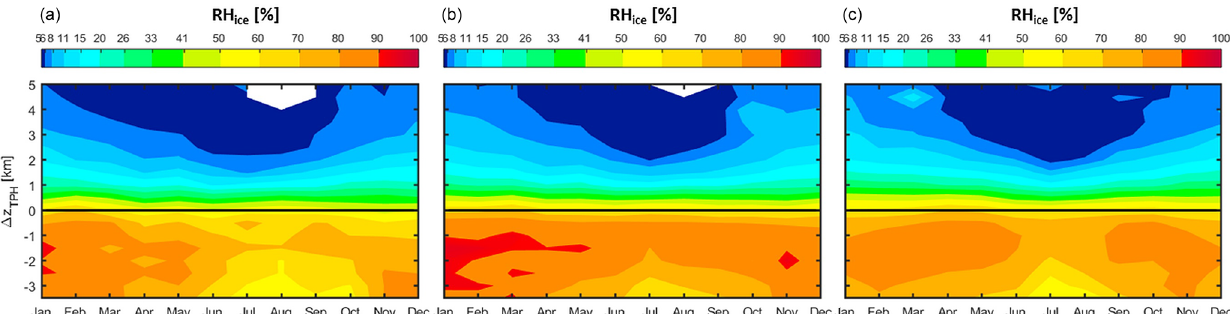
Figure 7. The 15-year averaged annual cycles of RH ice for latitudes 40 to 60 ◦ N and for the regions of (from a to c ) eastern North America (105 to 65 ◦ W), the North Atlantic (65 to 5 ◦ W) and Europe (5 ◦ W to 30 ◦ E).